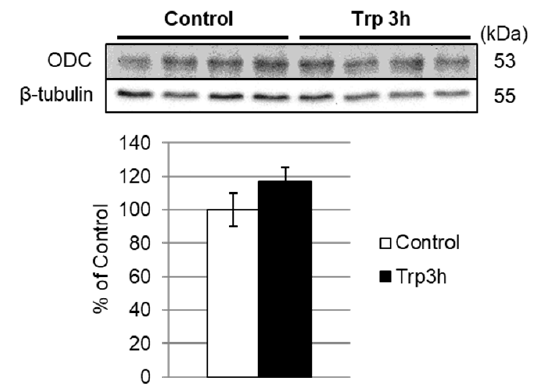
Figure 4. ODC (ornithine decarboxylase) expression did not alter after oral administration of Trp. Figure 4. ODC expression did not alter after oral administration of Trp. Liver lysates were Liver lysates were immunoblotted for ODC. The bar graph shows the ODC expression normalized immunoblotted for ODC. The bar graph shows the ODC expression normalized with β -tubulin with β -tubulin expression. Data are expressed as means ± SEM, n = expression. Data are expressed as means ± SEM, n = 4.